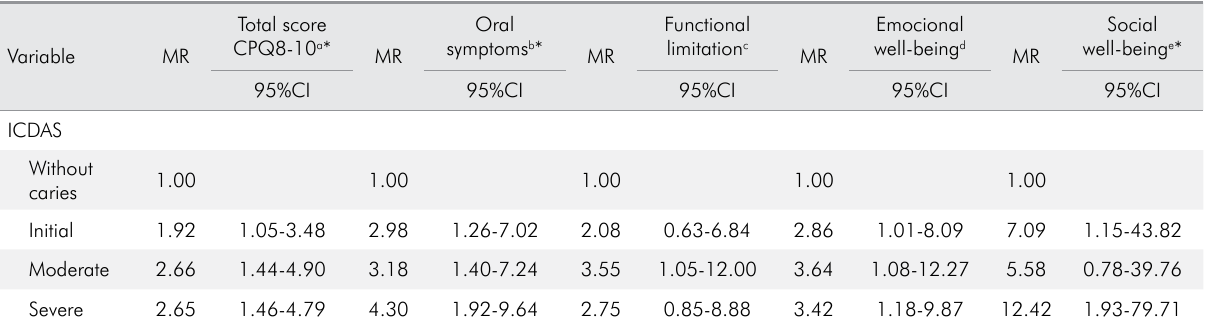
Table 3. Adjusted Poisson Regression models with robust variance of the association between caries severity according to the International Caries Detection and Assessment System (ICDAS) simplified in relation to oral health-related quality of life (OHRQOL), total score and by domains (oral symptoms, functional limitation, emotional well-being and social well-being). Pelotas, RS, Brazil (n = 119).